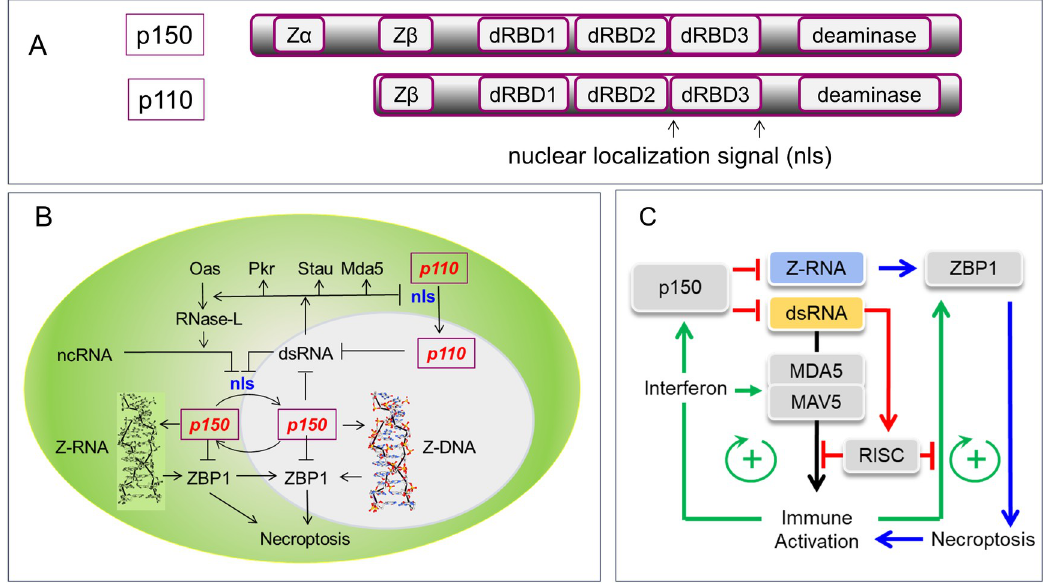
Fig 1. ADAR1 and Z-RNA. (A) Both p150 and p110 ADAR1 isoforms contain the same deaminase domain and dRBDs. Only ADAR1 p150 contains the Z α domain that binds both Z-DNA and Z-RNA. The function of the Z β domain is not known. (B) A cell with the cytoplasm in green and the nucleus shaded gray. While p110 is mostly nuclear, p150 undergoes cytoplasmic shuffling. Both isoforms have a bipartite nls that spans the third dsRBD3 B. The nls is inhibited by dsRNA (indicated by a “T” shaped arrow) that can be generated by nuclear export or from cytoplasmic nuclease processing of misfolded or noncoding RNAs. Cytoplasmic dsRNA can also affect other pathways by targeting MDA5 (activates interferon responses), Stau (Staufen decay pathway) [40], Pkr (effects on RNA translation) [41], and Oas (2 0 -5 0 -oligoadenylate synthetase that activates RNase-L to cleave noncoding RNAs like tRNA, Y-RNA, and ribosomal RNA) [42]. (C) MDA5 bound to dsRNA activates the MAVS protein to greatly increase the expression of interferon, ADAR1 p150, ZBP1, and other genes. ADAR1 p150 destabilizes dsRNA and inhibits ZBP1 induction of necroptosis [43]. The RISC uses miRNAs to target self-sequences. Both the formation of miRNAs and availability of target sequences are modulated by helicases [99,100].dRBD, double-stranded RNA binding domain; dsRBD3, dsRNA binding domain 3; MAVS, mitochondrial antiviral signaling; MDA5, melanoma differentiation–associated gene 5; miRNA, microRNA; nls, nuclear localization signal; Pkr, protein kinase R; RISC, RNA-induced silencing complex; ZBP1, Z-DNA binding protein 1.